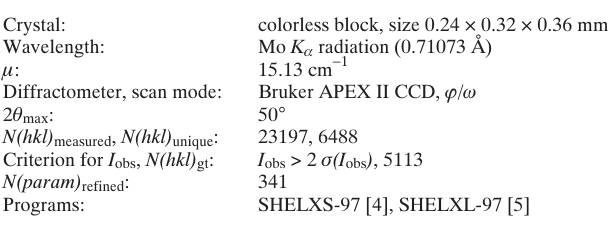
Table 1. Data collection and